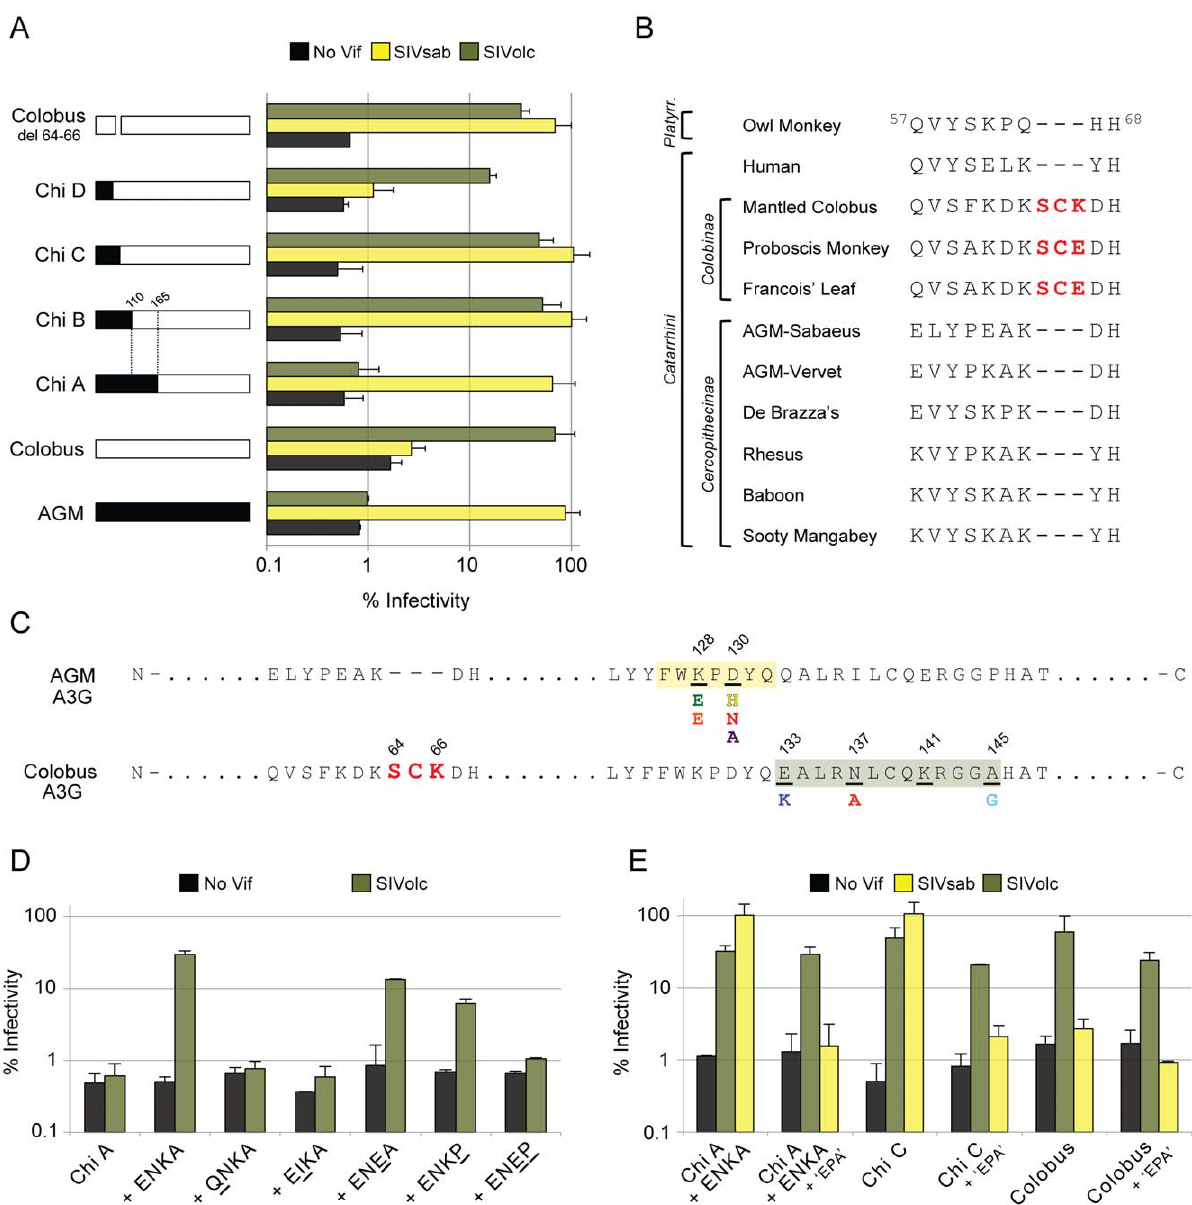
Figure 4. A multi-residue insertion that blocks Vif emerged 12 MYA in A3G of the Colobinae ancestor. (A) Single-round infectivity assays were performed with HIV-1 D Vif and HIV-1 expressing SIV Vif proteins produced in the presence of colobus/AGM chimeric A3G proteins. Infectivity of viruses is reported as a percentage, relative to infectivity in the absence of A3G (100%). Error bars indicate standard deviation from the mean of two independent transfection experiments (six infection replicates in total). (B) Partial protein alignment of A3G orthologs reveals a three-residue insertion (red) unique to members of the Colobinae subfamily of OWM. Members of primate parvorders Catarrhini (Old World Monkeys and Hominoids) and Platyrrhini (New World Monkeys) are included. Old World Monkeys are further divided into subfamilies Cercopithecinae and Colobinae . (C) Residues of A3G responsible for differential sensitivity to SIVsab and SIVolc Vif. The canonical Vif binding site is boxed in yellow. Divergent character states independently selected at residues 128 and 130 (underlined) of Cercopithecinae A3G are displayed below. The three-residue insertion in the N- terminus of colobus A3G is bolded in red. The residues of A3G required for antagonism by SIVolc Vif, as found in this study, are underlined and boxed in green. Divergent character states at residues 133, 137 and 145 identified in Colobinae A3G are displayed below. (D) and (E) Single-round infectivity assays were performed with HIV-1 D Vif and HIV-1 expressing SIVolc Vif produced in the presence of mutated colobus/AGM chimeras.